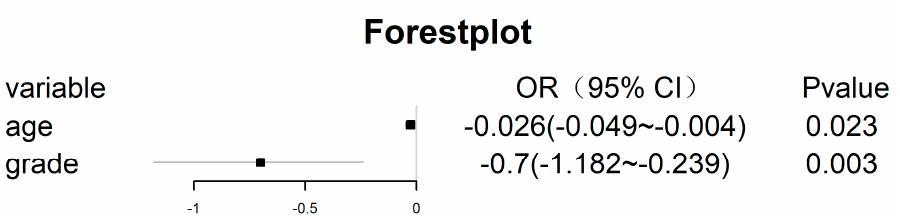
Figure 7. Variables included in the clinical model with the OR values of each variable and its 95% CI and p values.